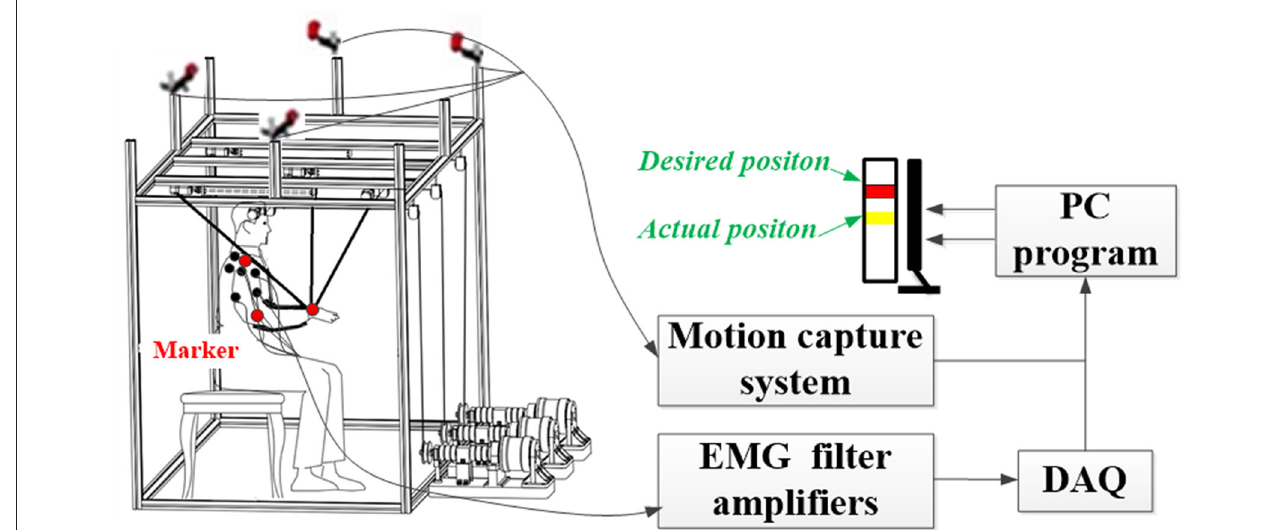
FIGURE 1 | Architecture of the cable-based rehabilitation robot.